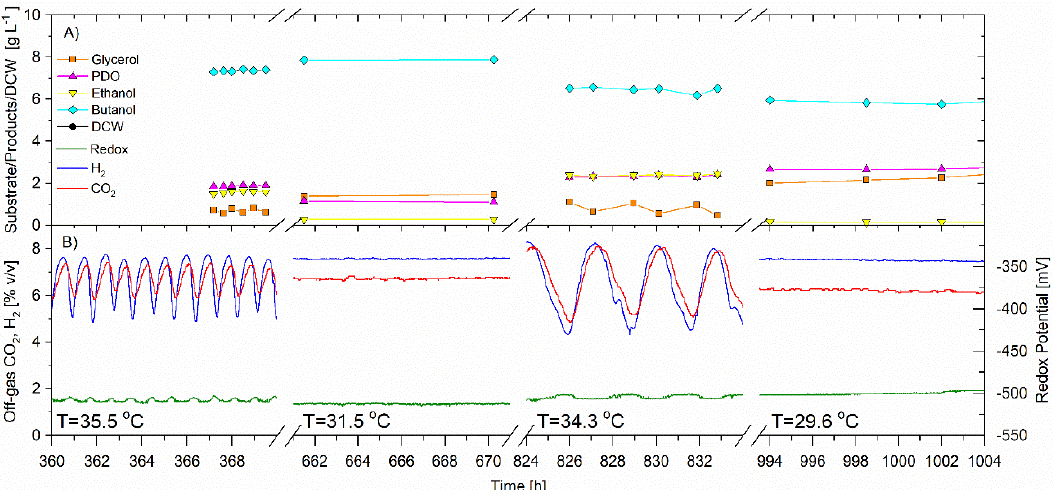
Figure 6. Continuous fermentation showing the effect of temperature on the self-synchronized oscillatory metabolism. Operating pH 5.0, D = 0.092 h − 1 . Feed glycerol: 31.1 ± 0.05 g·L − 1 Temperature 35.5 °C (252 – 537 h); 31.5 °C (537 – 687 h); 34.3 °C (687 – 906 h); 29.6 °C (906 – 1020 h) ( A ) Off-line analysis of bioreactor in g·L − 1 of: glycerol (solid orange square); PDO (solid magenta triangle); ethanol (solid inverted yellow triangle); butanol (solid cyan diamond) (B) On-line analysis of off-gas (sample frequency 1 min) of: CO 2 (red) and H 2 (blue), % v / v ; redox potential, mV (green). Lines joining data points are for visual purposes only.